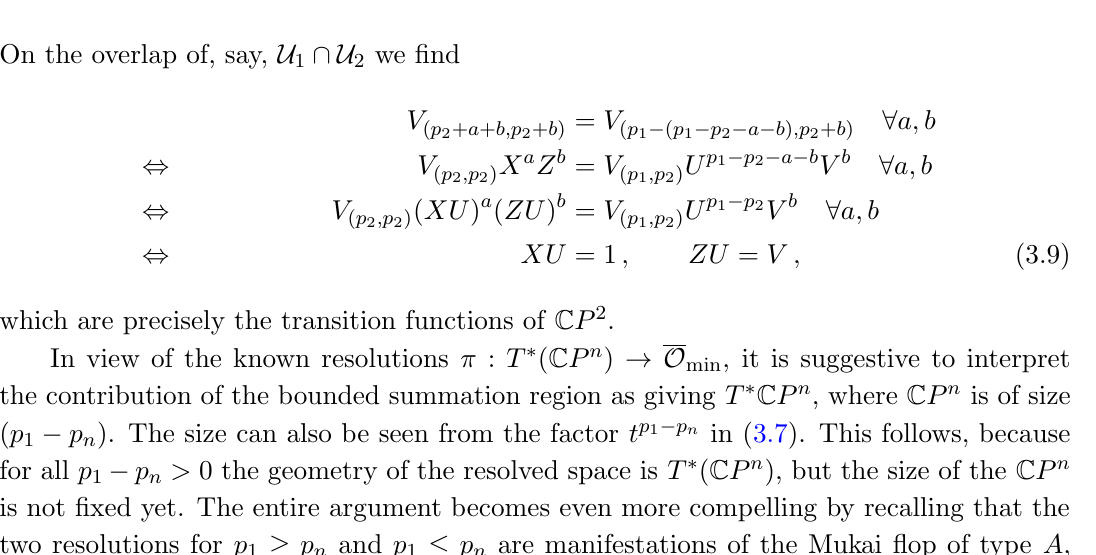
Figure 1 . The polytope P z arising in the monopole formula for the minimal nilpotent orbit closure of A 2